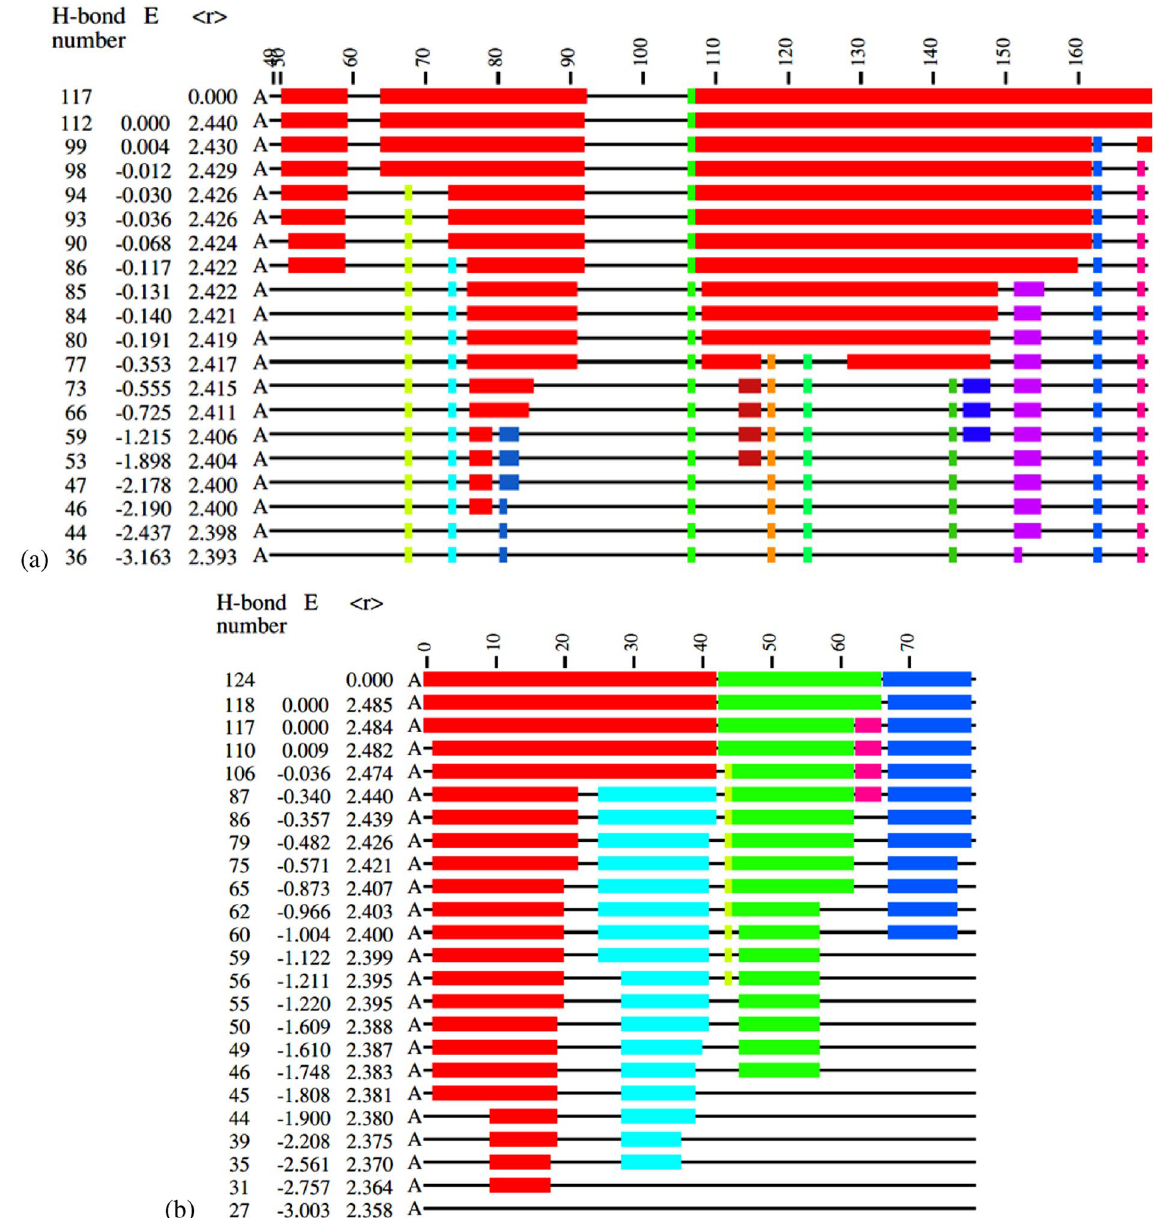
Figure 1. Examples of rigid cluster decompositions for different SARS-CoV-2 protein structures. ( a ) Shows the cluster decomposition for the crystal structure of the SARS-CoV-2 nucleocapsid protein N-terminal RNA binding domain (PDB: 6m3m) while ( b ) gives chain A of the co-factor complex of NSP7 and the C-terminal domain of NSP8 from SARS CoV-2 (PDB: 6wiq). Different rigid clusters of the polypeptide chain appear as coloured blocks along the protein chain with each C α labelled from its N-terminal at 1 to its C-terminal. The three columns at the left of each cluster decomposition denote the index of the hydrogen bond to have been opened last (with 117 and 124 to total number of H bonds in ( a ) and ( b ), respectively), the energy cutoff E cut (E) and the mean number of bonded neighbours (cid:31) r (cid:30) (mean coordination) at that value of E cut . The label A indicates that protein chain A is being considered from the structure. We emphasize that the E cut scale is not linear since new rows are only added when the rigidity of a structure has changed. When the value of E cut decreases (the downward direction points towards larger, negative E cut magnitudes), rigid clusters break up and flexibility increases. The colour coding shows which atoms belong to which rigid cluster. Flexible regions appear as thin black